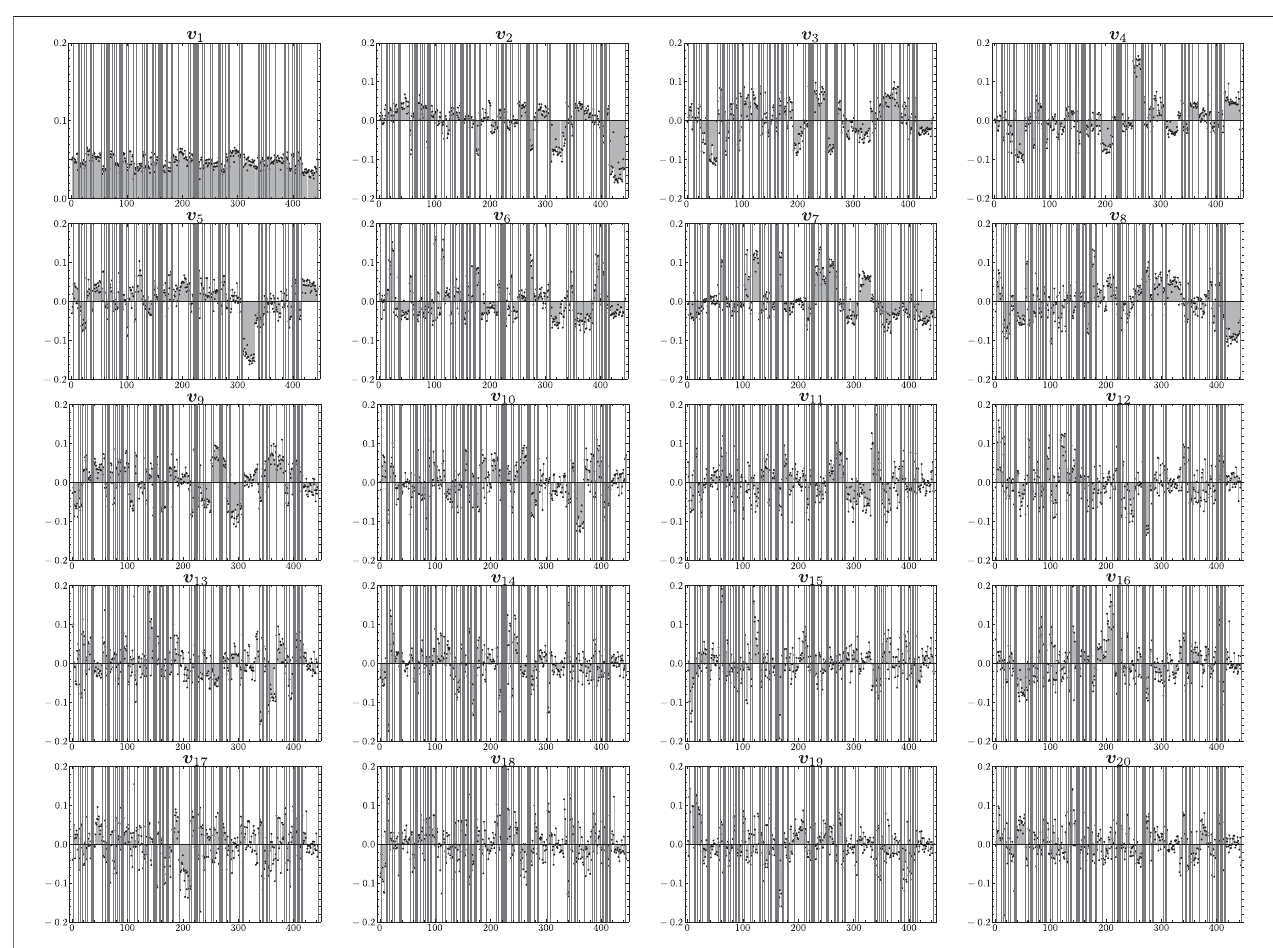
FIGURE 5 | Distribution of components of the top 20 eigenvectors, v 1 , ... , v 20 . The abscissa represents n , and the ordinate represents to the components v R , n of eigenvector v R . Here, R is the eigenvalue rankings. The thin vertical lines in these fi gures separate business sectors.